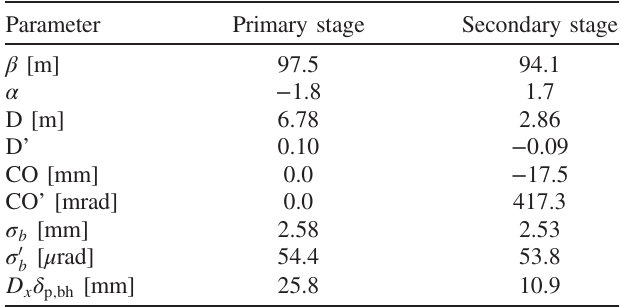
TABLE IV. Linear horizontal optics functions at the primary collimator and absorber (TIDP) for the Q20 optics. Values of a betatron σ for a normalized emittance of 1 . 89 μ m and the value